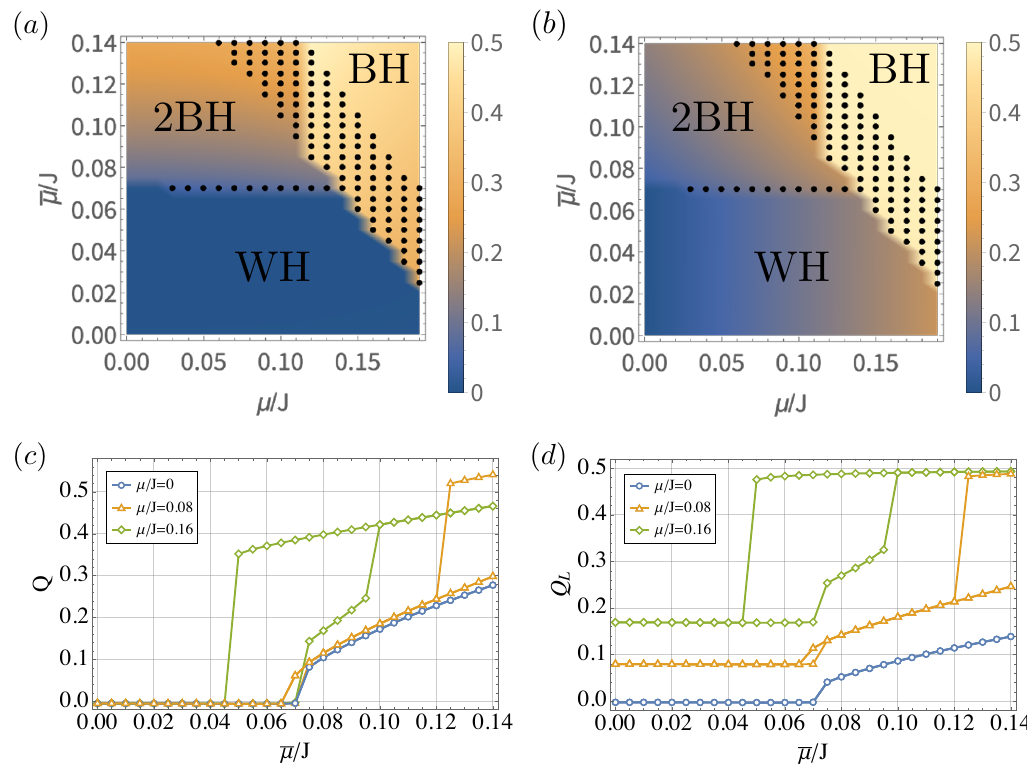
Figure 3 . The phase diagram of the model considered in this paper with βJ = 120 and µ c /J = 0 . 05 . Here we focus on moderate ¯ µ/J , with the wormhole phase, the two black hole phase, and the single black hole phase. We show the density plot for Q in (a) and for Q L in (b). Multiply saddle points exist in the dotted region. We also plot corresponding 1D curves with fixed µ/J in (c) and